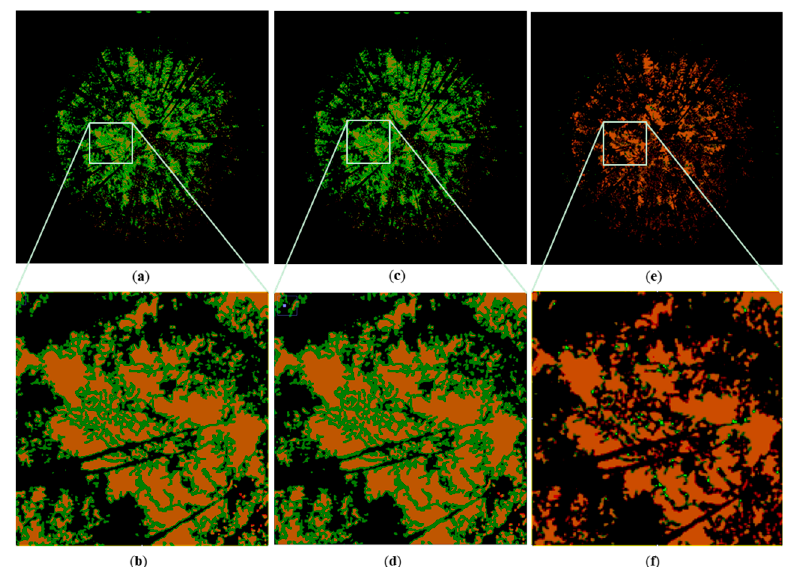
Figure 7. Comparison of segmentation results for six different methods: ( a ) Original canopy hemispherical photography (CHP) images; ( b ) manually extracted reference images, segmentation results obtained from ( c ) newly developed U-net method as well as from ( d ) Otsu; ( e ) Ridler; ( f ) fuzzy clustering method (FCM); ( g ) WinSCANOPY; ( h ) Habitat-Net methods.